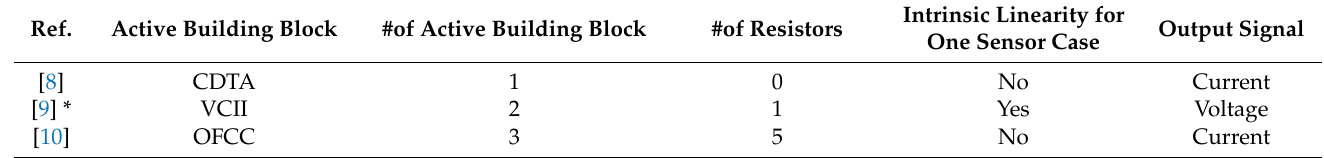
Table 3. Comparison between a VCII-based CMWB read-out circuit and conventional ones. Ref.